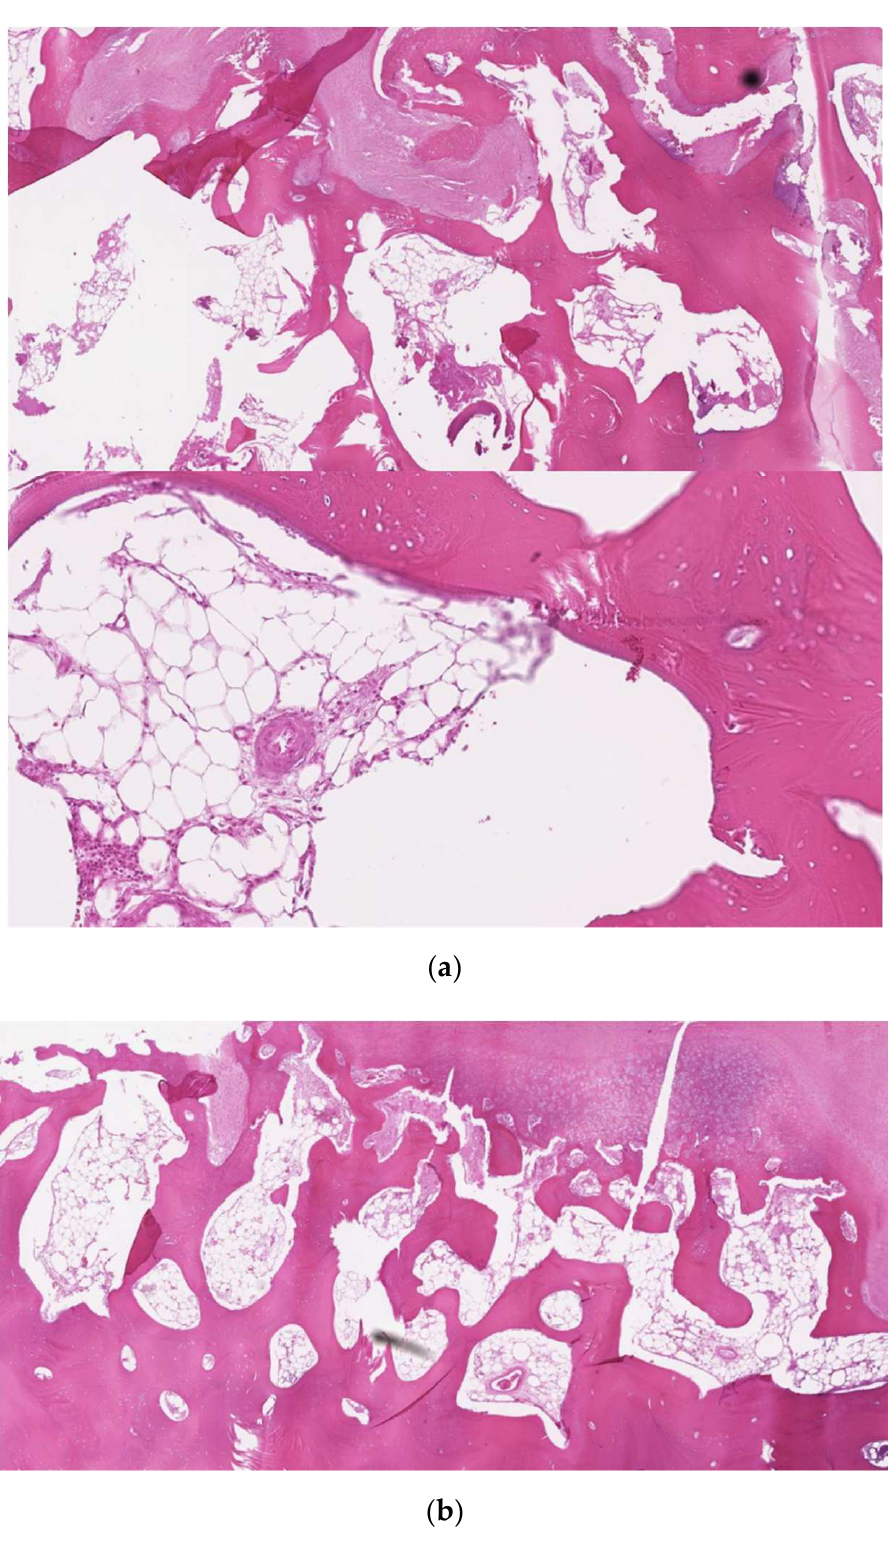
Figure 9. Hematoxylin–eosin staining of the lesion. Sections of compact, trabecular bone tissue covered by a layer of hyaline cartilage and fibrous cartilage overlaid by dense fibrous connective tissue ( a , b ).